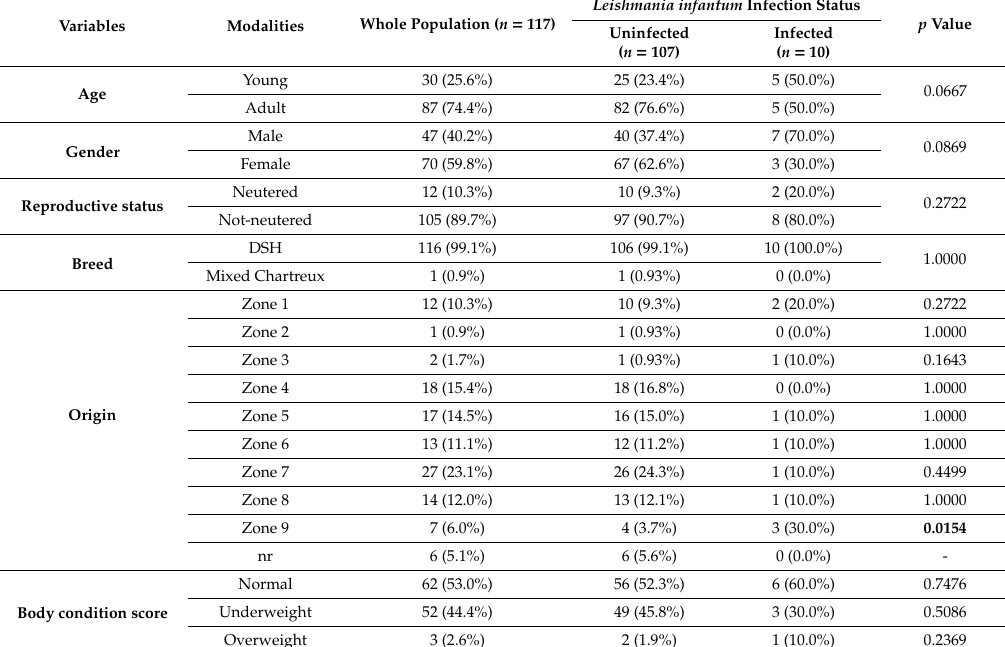
Table 1. Demographic, physical, clinical data, and retroviral status of whole stray cat population, with both Leishmania infantum uninfected and infected cats. Due to insu ffi cient volume of samples, only 95 cat samples were tested for of feline immunodeficiency virus (FIV) and feline leukemia virus infection (FeLV)